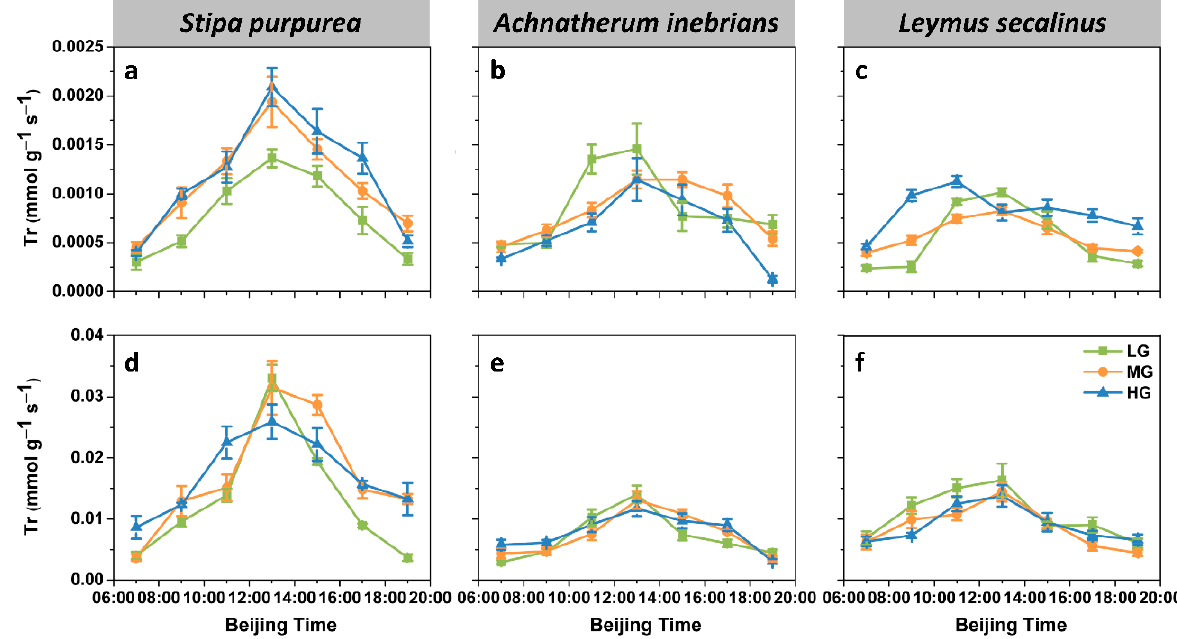
Figure 5. Diurnal dynamics of the transpiration rate (Tr) of the leaves and spikes of S. purpurea ( a , d ), A. inebrians ( b , e ) and L. secalinus ( c , f ) in response to grazing intensity (LG, light grazing; MG, medium grazing; HG, heavy grazing). The data are presented as mean ± standard error (SE) of three independent experiments.